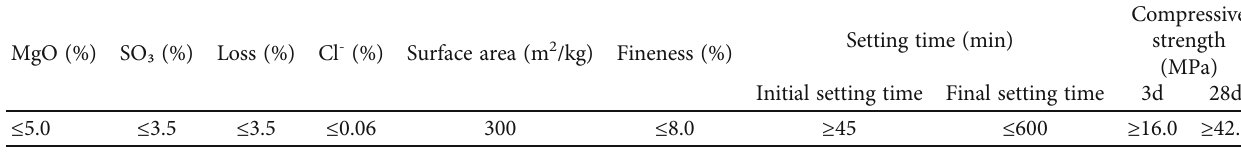
Table 2: Properties of ordinary Portland cement.